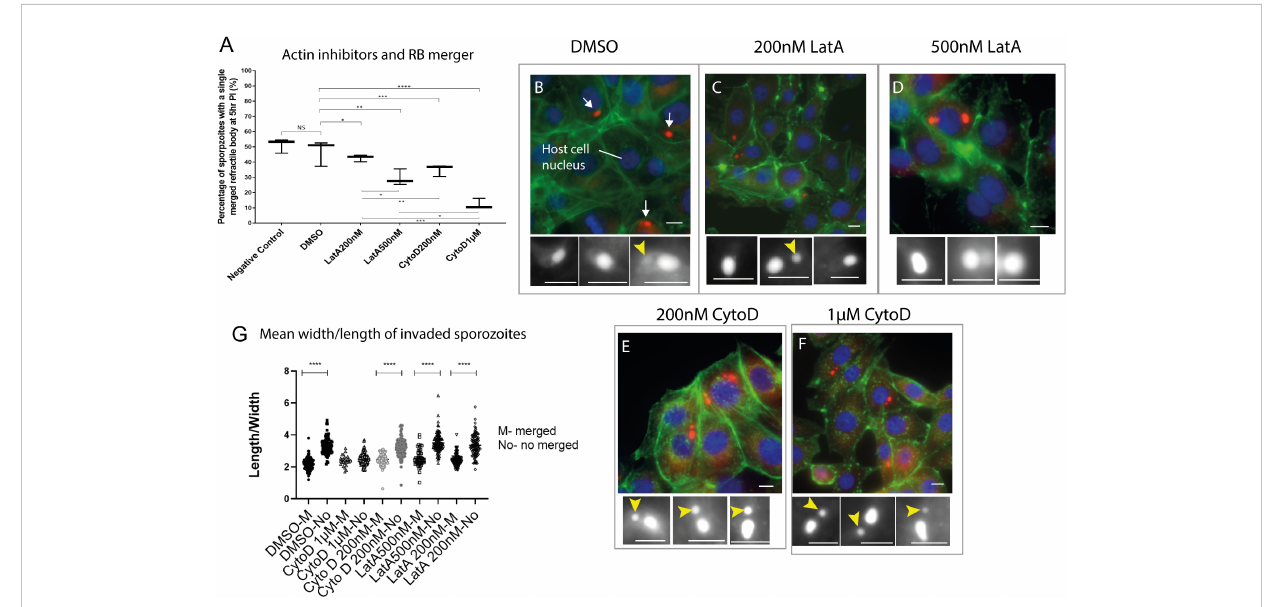
FIGURE 4 Effects of actin inhibitors on refractile body merger and morphology changes in intracellular sporozoites. (A) . Inhibition RB merger following treatment with actin inhibitors. DMEM - negative control, DMSO only control, 200 nM Latrunculin A (LatA), 500 nM Latrunculin A, 200 nM Cytochalasin (CytD) or 1µM Cytochalasin D; NS = not signi fi cant, *p ≤ 0.05, **p ≤ 0.01, ***p ≤ 0.001 - One Way ANOVA and post-hoc Turkey test) (n=100 cells/treatment). (B – F) Light microscopy data of sporozoites (arrows) within MDBK cells incubated in the presence of DMSO, 200 nM Latrunculin A, 500 nM Latrunculin A, 200 nM Cytochalasin or 1 µM Cytochalasin D. For each condition, sporozoites were assessed for the presence of an RBant. (yellow arrowhead). Nile Red staining highlights the RB (red) (white in the cropped images), Hoechst staining localises to the host cell nucleus (blue) and Phalloidin 488 localises to the host cell actin (green); (G) Comparison of cell rounding following 5 hours incubation with each treatment. Scale bars = 20µm. ****p <